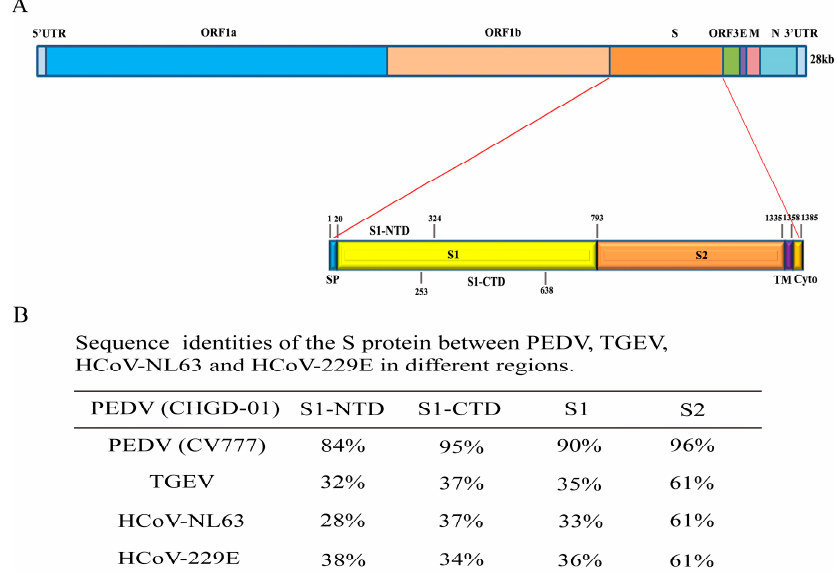
Figure 1. The S protein of PEDV. ( A ) Schematic diagram of the PEDV genome organization and the deduced domains of the S protein, including the signal peptide (SP); S1 region, which includes S1-NTD (residues 21–324) and S1-CTD (residues 253–638); S2 region; transmembrane domain (TM); and cytoplasmic tail (Cyto); ( B ) Sequence identities of the S protein between PEDV, TGEV, HCoV-NL63, and HCoV-229E in different regions. The sequences of the S1-NTD, S1-CTD, S1 and S2 regions of the PEDV CHGD-01 strain were compared with those of the corresponding regions of the PEDV CV777 strain, TGEV, HCoV-NL63, and HCoV-229E.